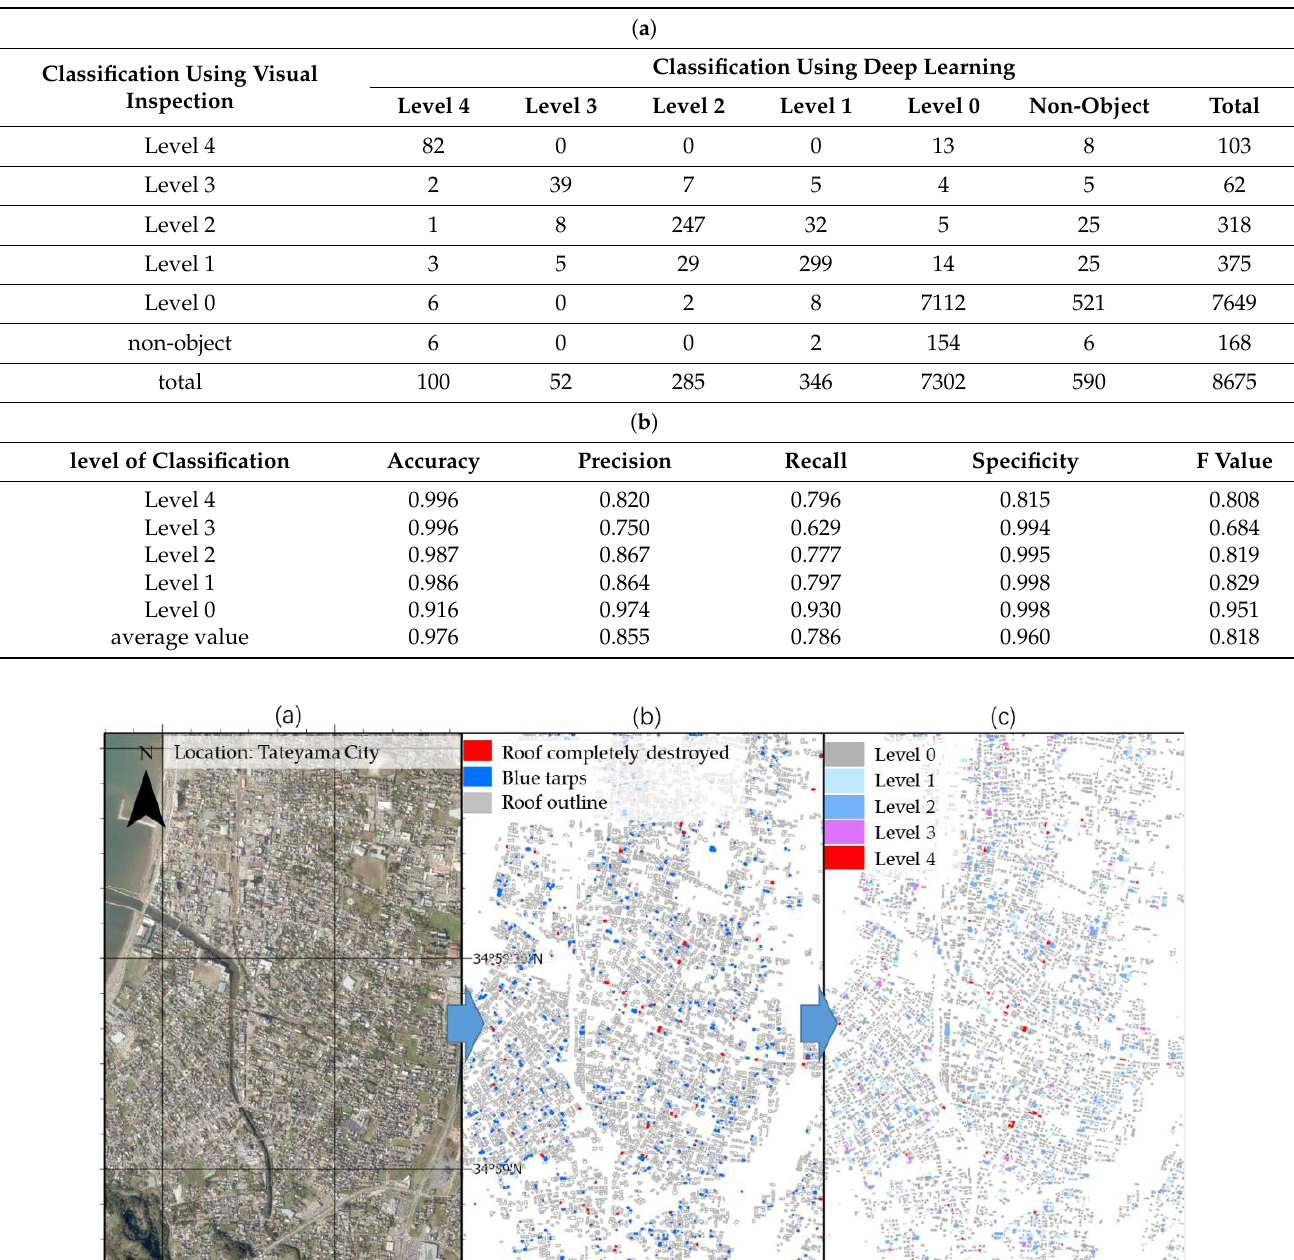
Table 6. ( a ) Evaluation of test results using confusion matrix. ( b ) The accuracy and F value of the confusion matrix.